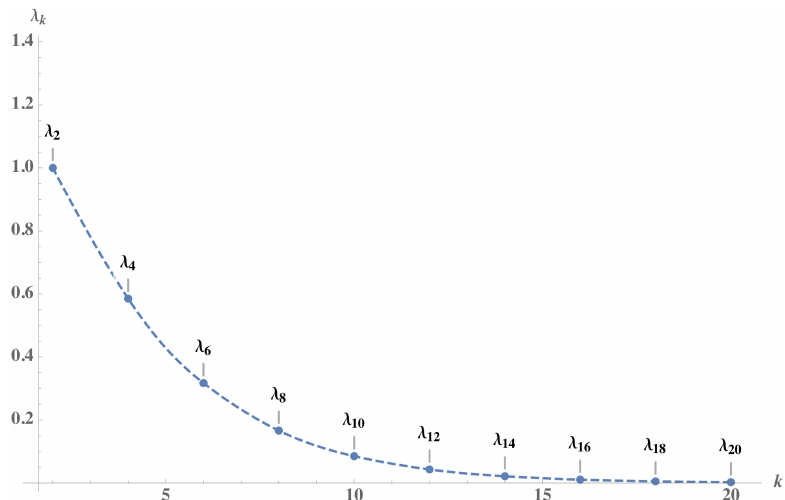
Figure 1 . The coupling constants λ k for even k ≥ 2 , without dynamical gravity, must obey the conditions (1.3)–(1.5). There is always some choice of the scale M (and µ ) for which the coupling constants have this generic structure. When gravity is included, only bounds on λ